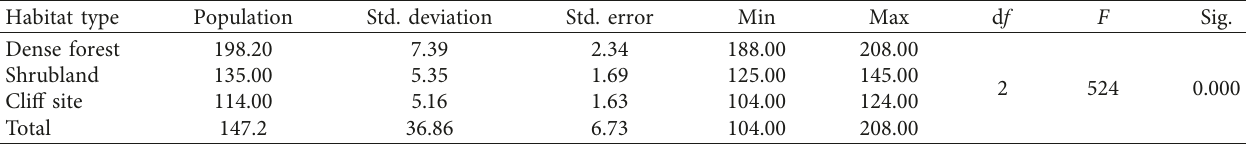
Table 5: Number of mammalian populations among habitat types.